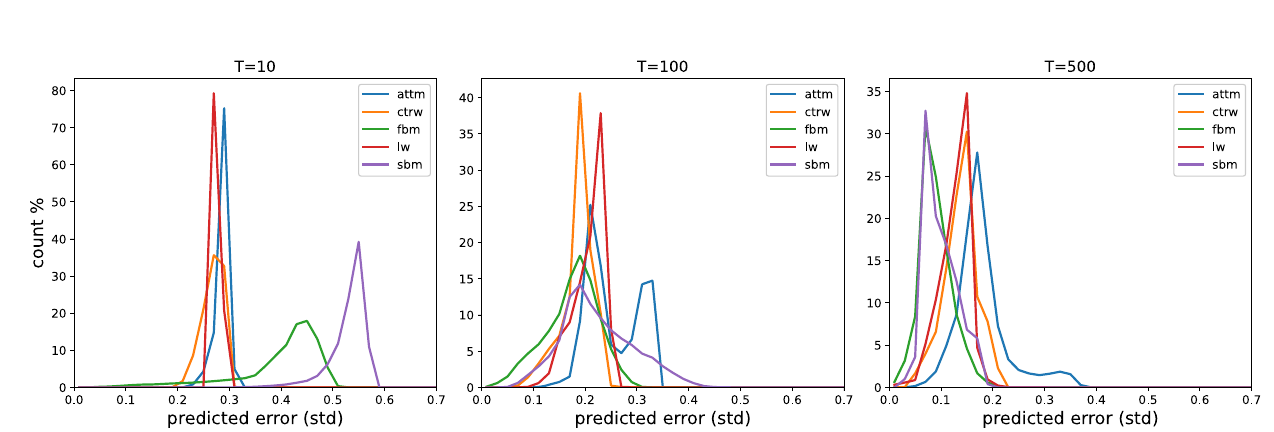
Fig. 5 | Predicted error histogram for inferring the anomalous diffusion expo- nent when the underlying model is known. The fi gure shows the distribution of the error as predicted by neural networks trained individually for each model. The